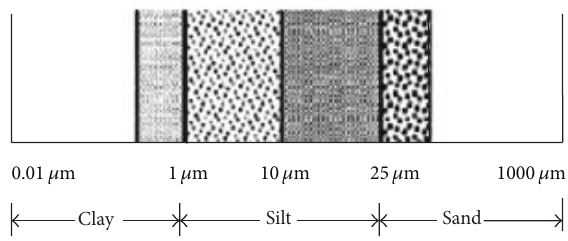
Figure 2: The size range of four soil particles classes [19].